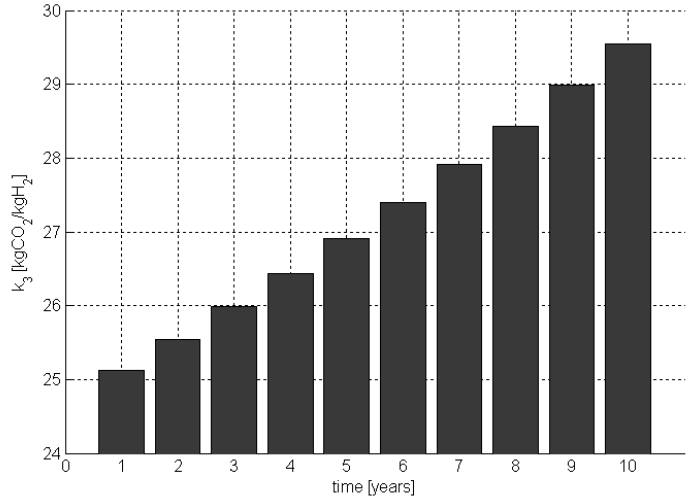
Figure 13. Change in the value of decision criterion k 3 for V3—own study.